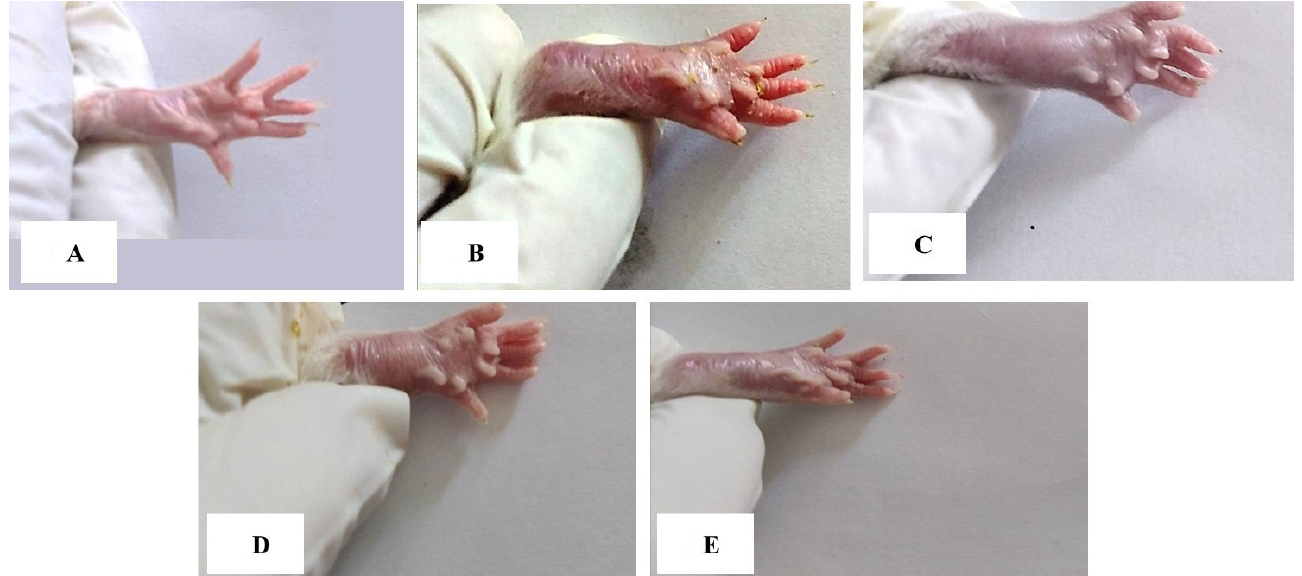
Figure 2. Gross morphology of right hind leg paw and ankle of rats showing swelling and inflammation in rats of different groups. ( A ): Ankle joint and paw of normal rat, ( B ): Ankle joint and paw of arthritic rat, ( C ): Ankle joint and paw of arthritic rats treated with diosmin, ( D ): Ankle joint and paw of arthritic rats treated with trolox, and ( E ): Ankle joint and paw of arthritic rats treated with diosmin and trolox.